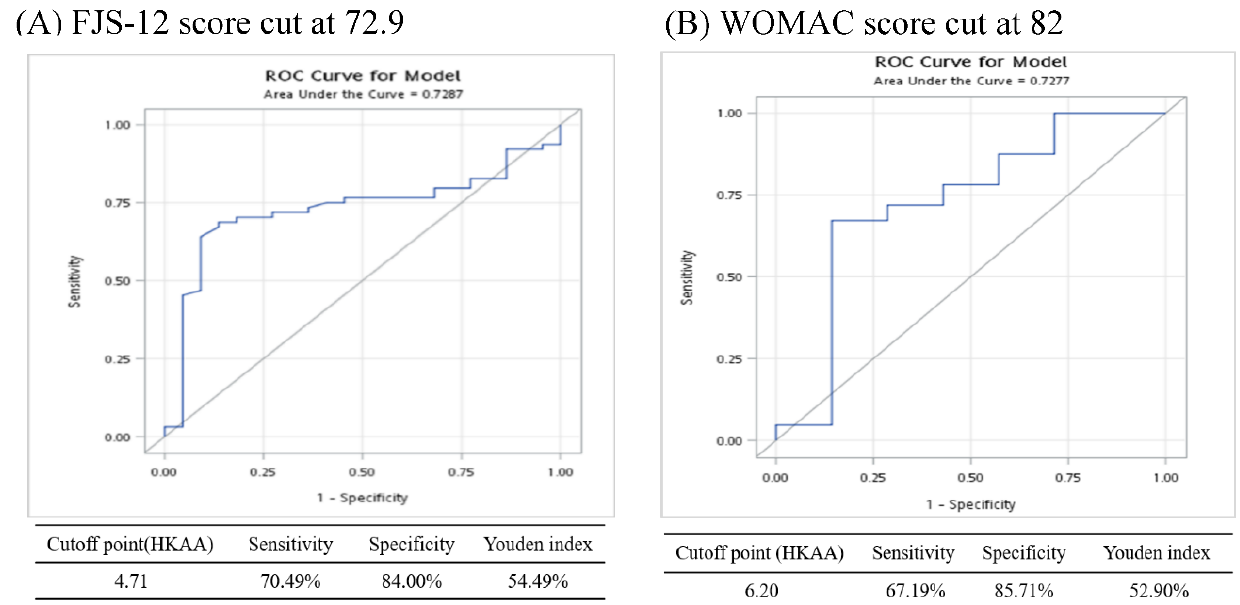
Figure 3. The ROC curve of ( A ) HKAA for FJS-12 score cut at 72.9 and ( B ) HKAA for WOMAC score cut at 82.